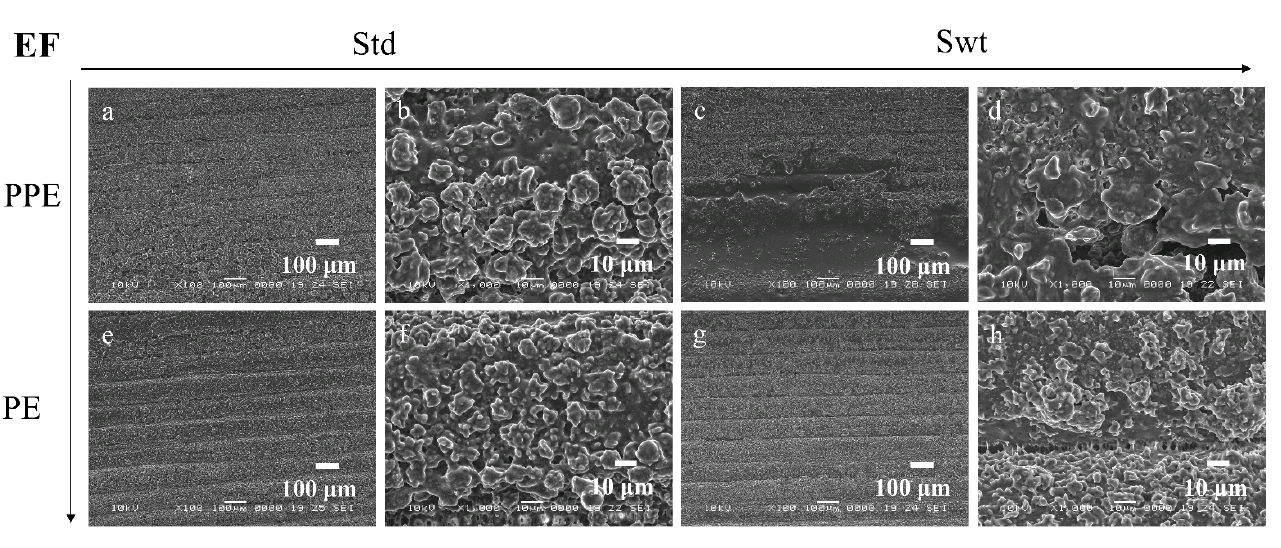
Figure 11. SEM images of EF biofilms in standard ( a , b , e , f ) and switched ( c , d , g , h ) samples on ( a ) × 100, ( b ) × 1000, ( c ) × 100 and ( d ) × 1000 PPE side; ( e ) × 100, ( f ) × 1000, ( g ) × 100, and ( h ) × 1000 PE side of the channel.